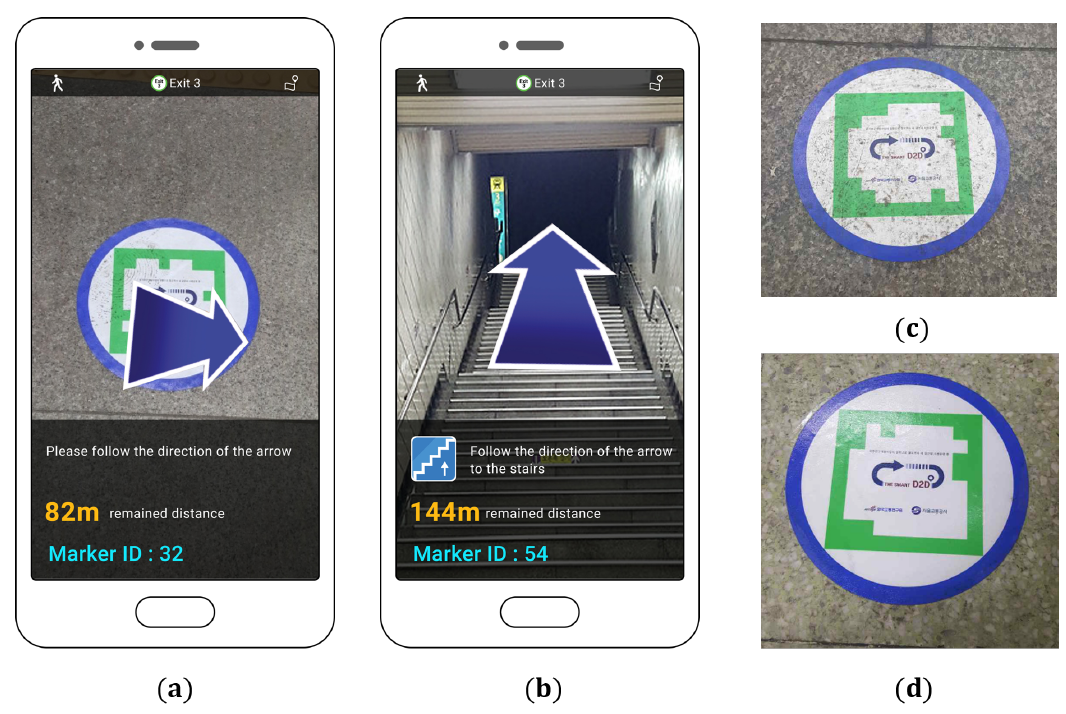
Figure 9. Guide screen of the HMIPS: ( a , b ); installed marker: ( c , d